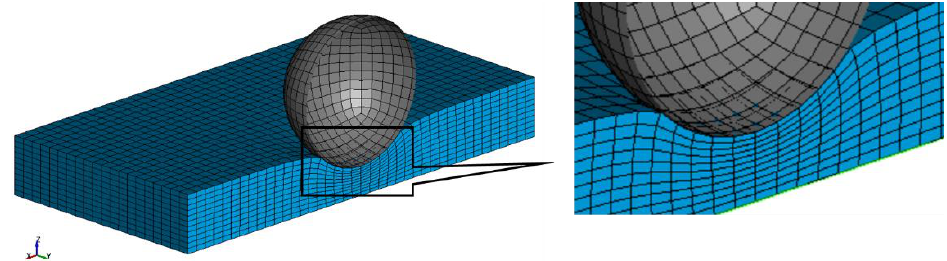
Figure 12. Simulation of a spherical indentation test for a battery cell with a homogeneous mod- elling strategy.